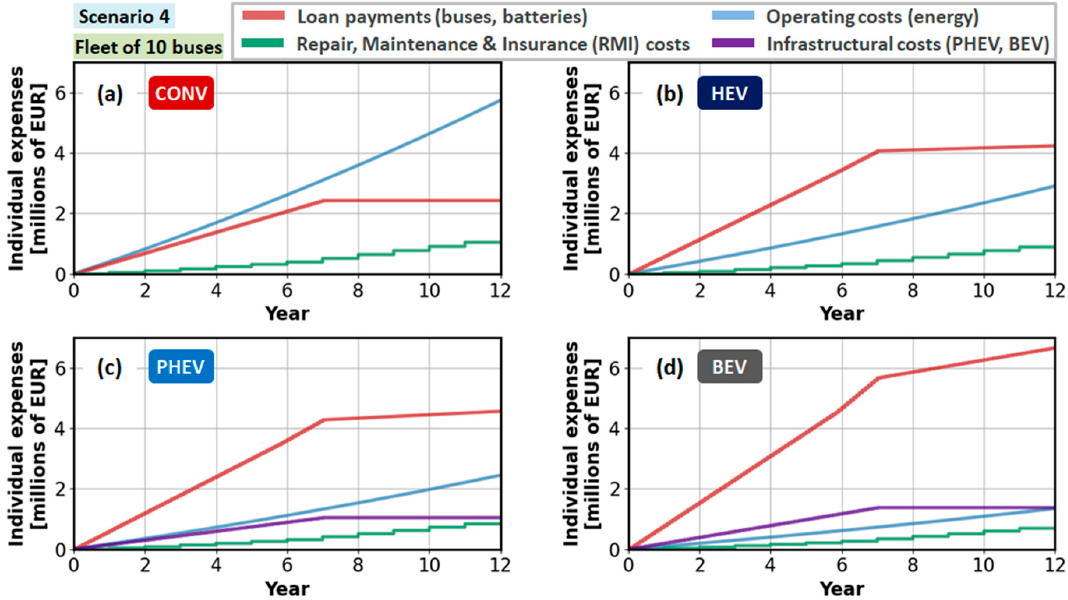
Figure 21. Time profiles of individual TCO costs for different type of bus fleets and Scenario 4 from Figure 18.